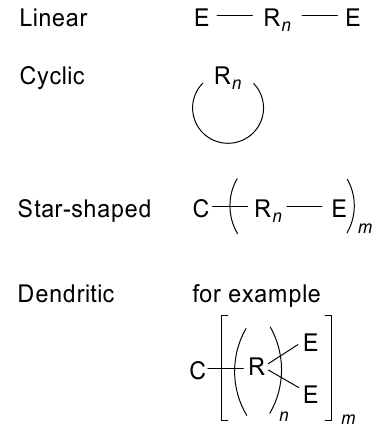
Figure 1. Structure types of conjugated oligomers.